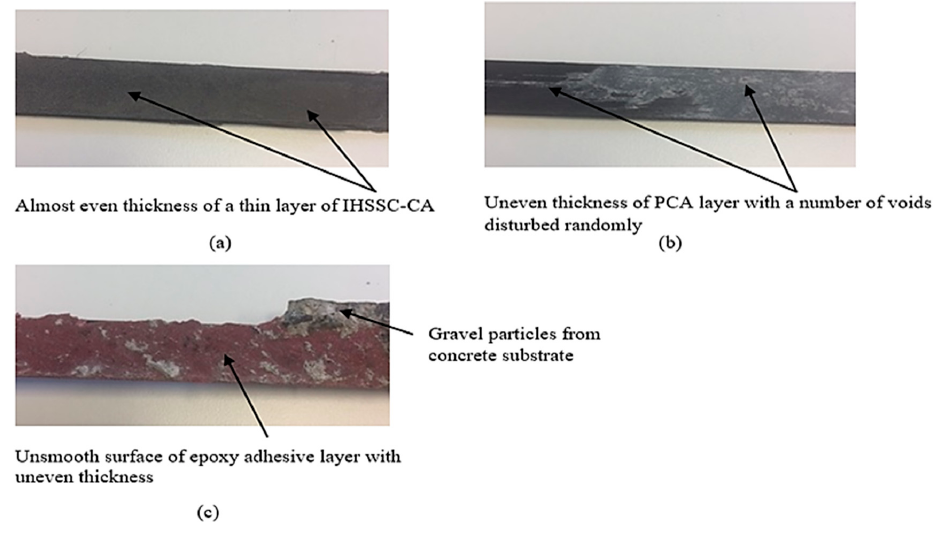
Figure 6. Images of bond area after pull-out testing, ( a ) IHSSC-CA specimen; ( b ) PCA specimen; ( c ) EA specimen.